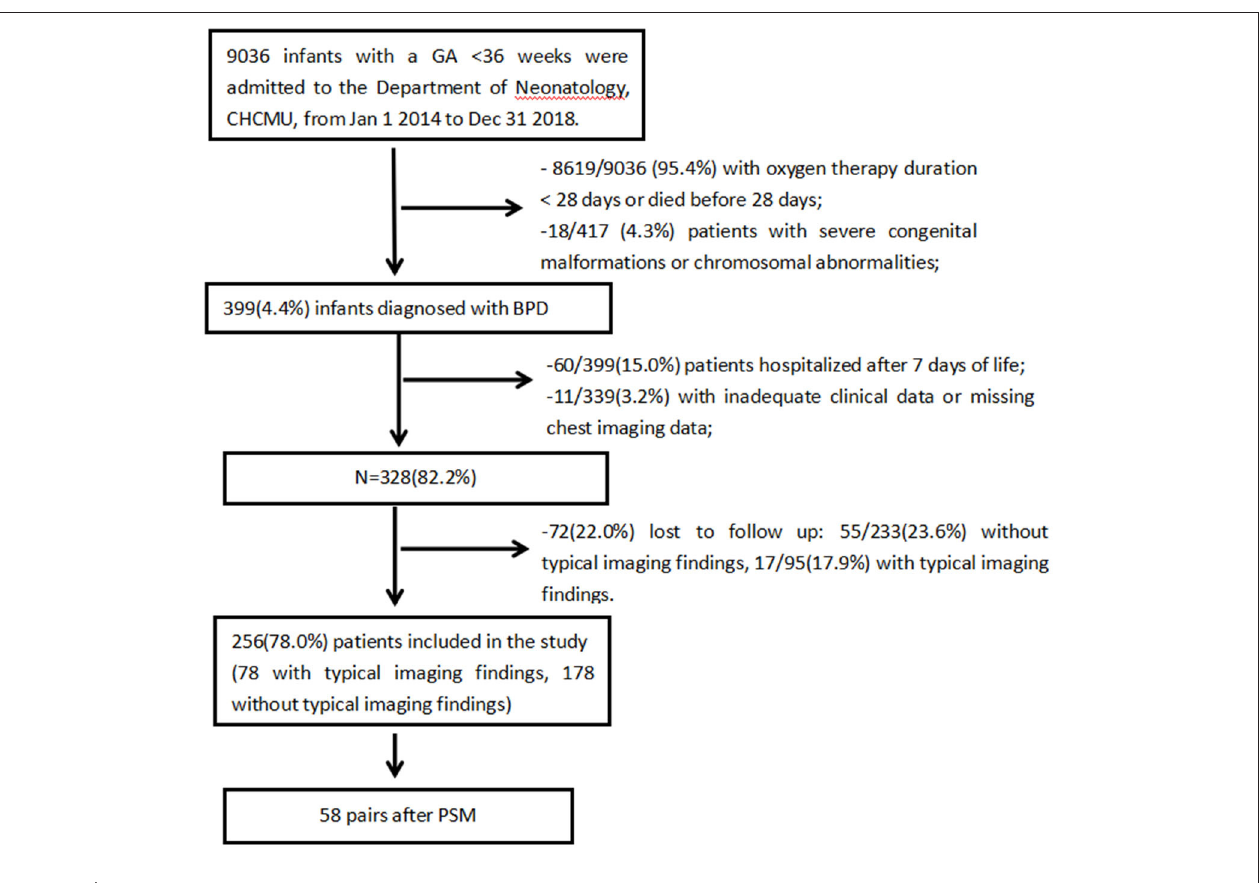
FIGURE 1 | Flowchart of the inclusion process.